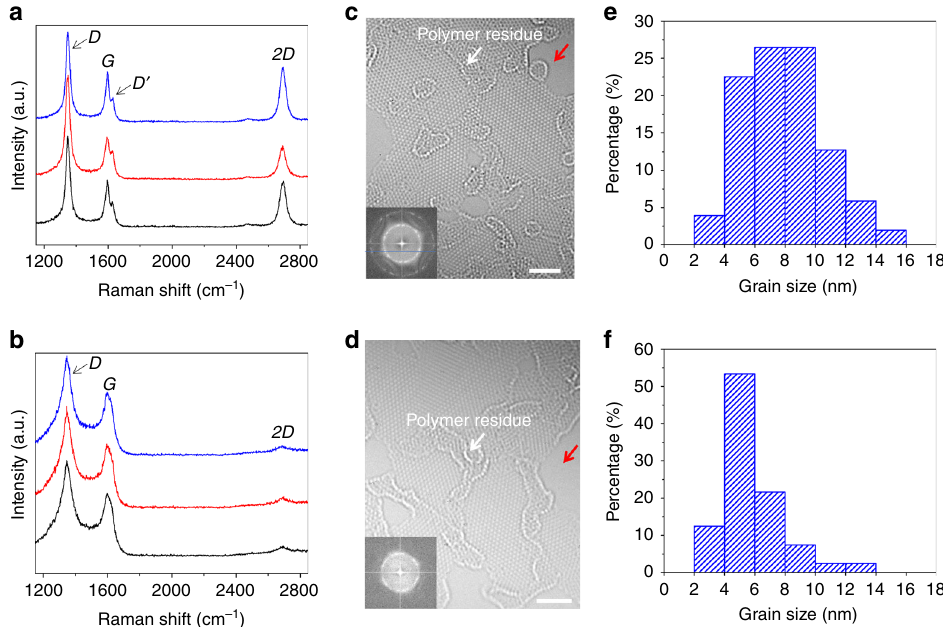
Fig. 3 Characterizations of the 8.0 nm-grained and 5.8 nm-grained NG fi lms. a , c , e , Raman spectra taken from randomly selected three positions a , typical HRTEM image c , and the histogram of the grain size extracted from HRTEM measurements e of 8.0 nm-grained NG fi lm. b , d , f , Raman spectra taken from randomly selected three positions b , typical HRTEM image d , and the histogram of the grain size extracted from HRTEM measurements f of 5.8 nm-grained NG fi lm. Insets in b and d , Fourier transform patterns. To expose the GBs, the samples were annealed at 320 °C in air for 8 h to remove the adsorbed PMMA residues, which simultaneously generates some holes as denoted by a red arrow. Scale bars: c , d , 2 nm